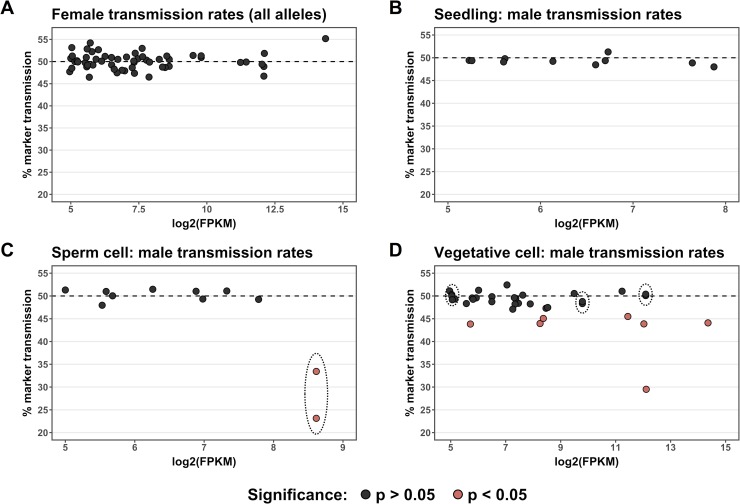
Functional validation of highly-expressed gametophyte genes by quantification of transmission rates in Ds-GFP insertional mutants.Alleles with CDS insertions were tested for differences from Mendelian inheritance using a quasi-likelihood test, with p-values corrected for multiple testing using the Benjamini-Hochberg procedure; alleles with quasi-likelihood adjusted p-value < 0.05 are represented in pink. Alleles are plotted by the log2(FPKM) of their respective gene according to that gene’s expression class (Seedling, Vegetative Cell, or Sperm Cell). Insertion alleles distributed among the classes as follows: Vegetative Cell, 35 alleles; Sperm Cell, 11 alleles; Seedling, 10 alleles. The number of seeds categorized for each allele ranged from 1,522 to 5,219, with an average of 2,807. Genes represented by two independent insertion alleles are enclosed by dotted lines. (A) Transmission rates of 56 mutant allele seed markers for heterozygous Ds-GFP mutant plants crossed through the female. (B) Transmission rates for alleles in the negative control Seedling class when crossed through the male. (C) For genes belonging to the Sperm Cell class, one out of ten (10%) was associated with significant non-Mendelian inheritance. The single gene with a male transmission defect in this group (gex2) showed a strong defect for both of the independent alleles tested. (D) An increased proportion of the genes in the Vegetative Cell class were associated with significant non-Mendelian inheritance when mutant (7/32 genes, 21.9%). In this class, an increase in log2(FPKM) was significantly associated with a decrease in marker transmission (linear regression, p = 0.0120).